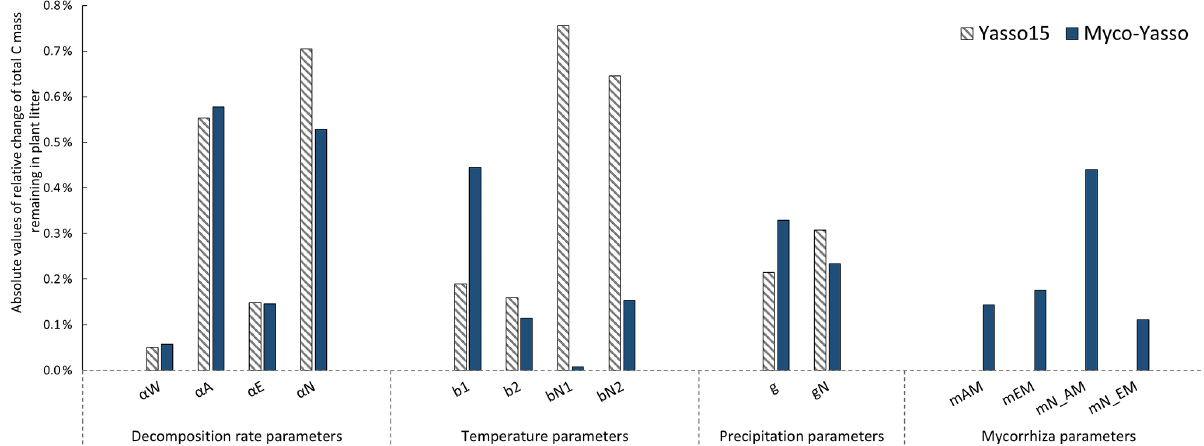
Figure 6. Model sensitivity to 1% increase in individual litter decomposition parameters.